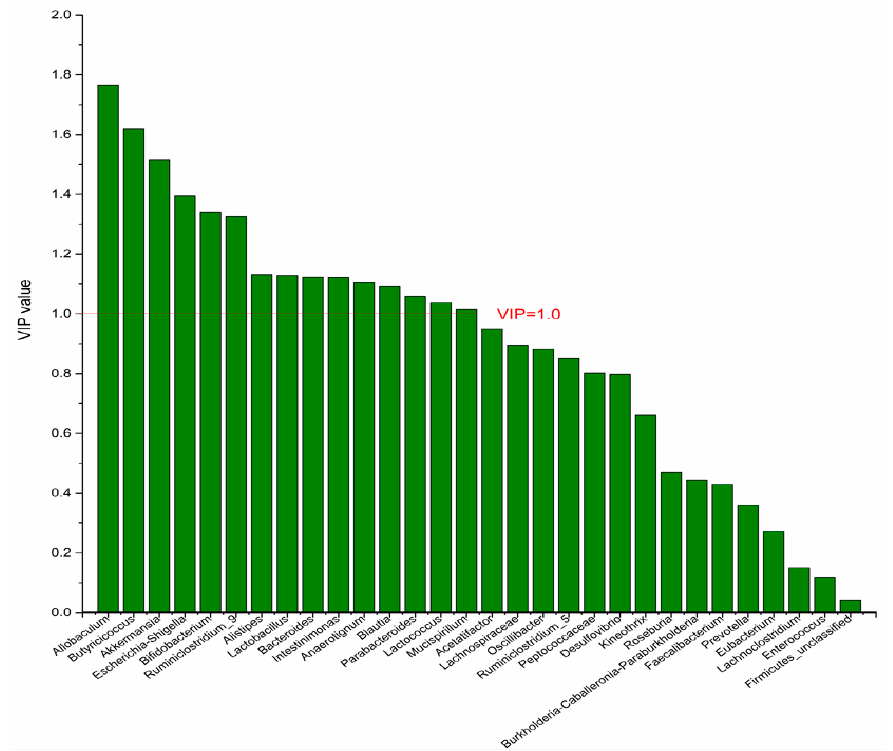
Figure 5. The VIP plot of the differential bacterial genera in DPA group vs. EPA group.